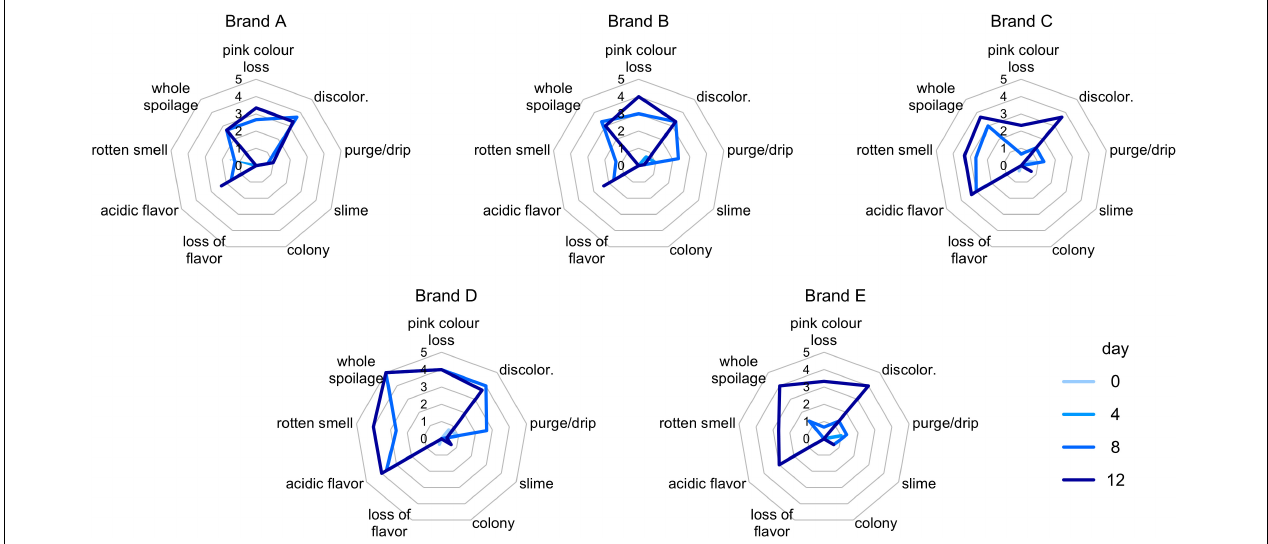
FIGURE 1 | Spider charts for scores (0–5) of sensory defects detected in (A–E) samples, with different color lines for each